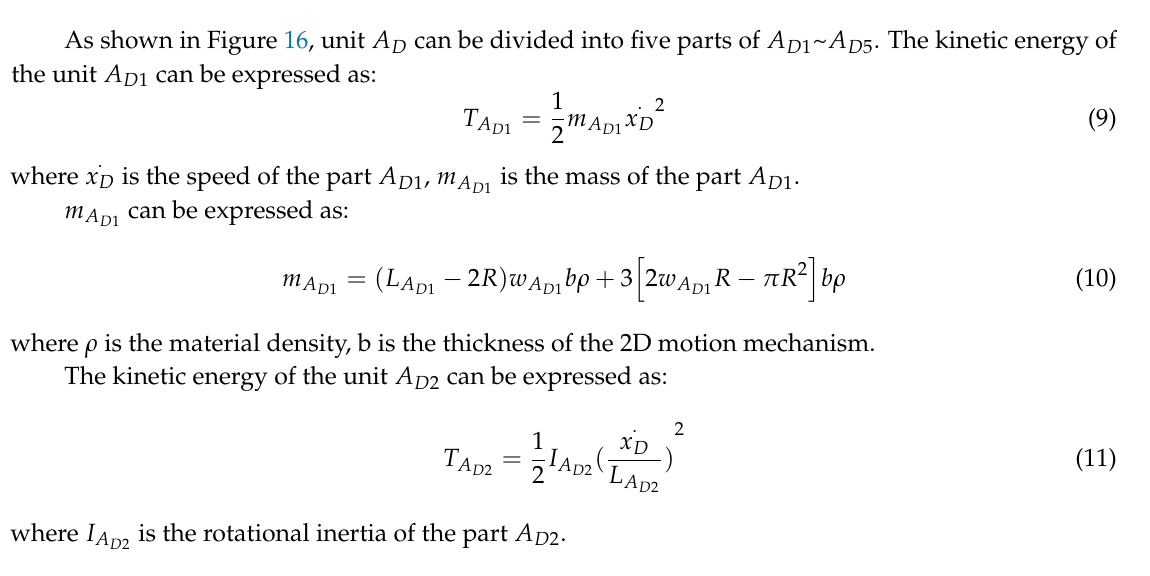
Figure 15. Three-dimensional motion device structure.